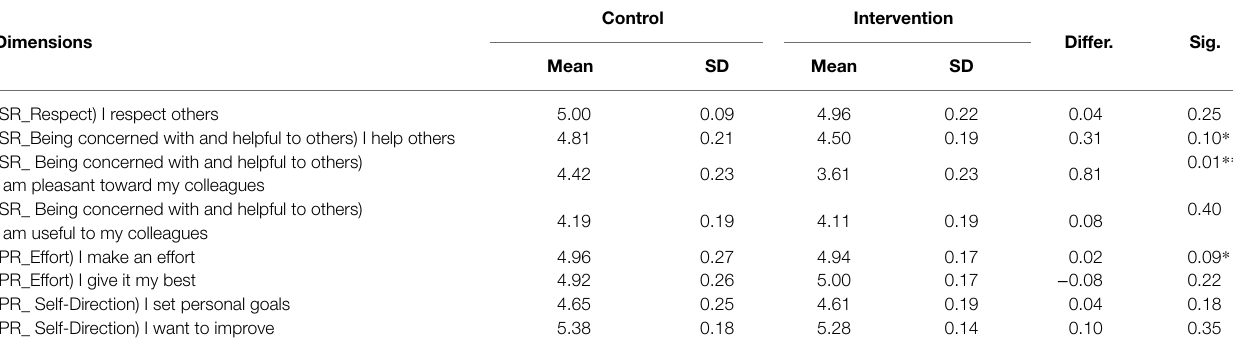
TABLE 7 | Mean, standard deviation and differences between means, of the intervention group and the control group. Dimensions